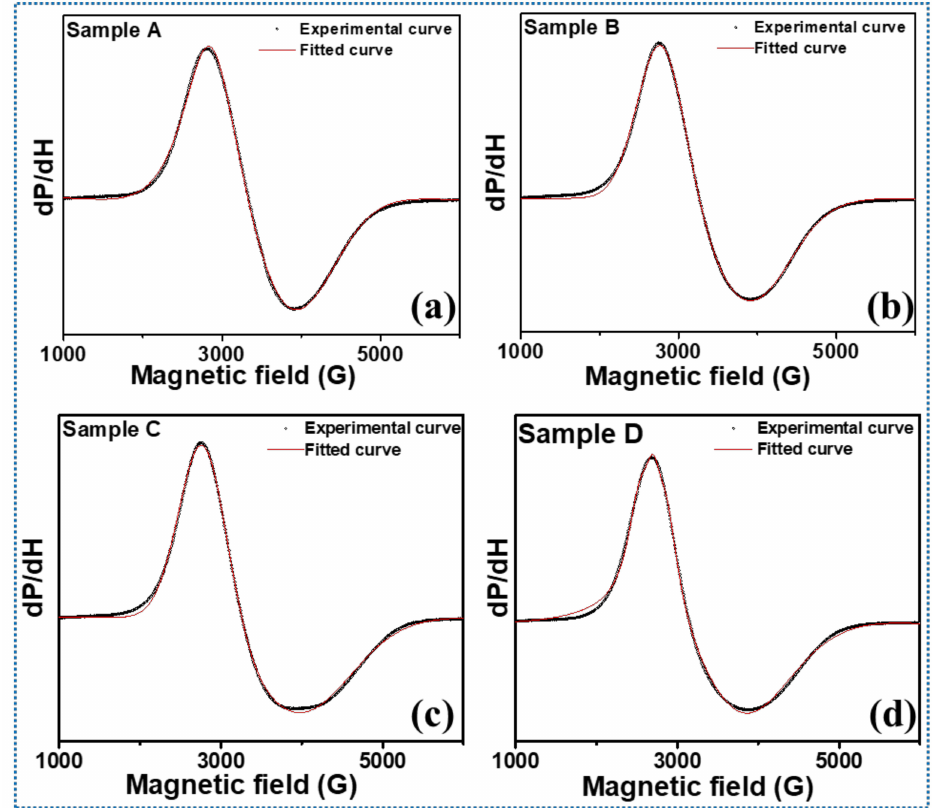
Figure 11. ( a – d ) FMR spectra of the respective AMF samples A, B, C, and D with the experimental curve are shown with hollow circles and the solid red lines show the best